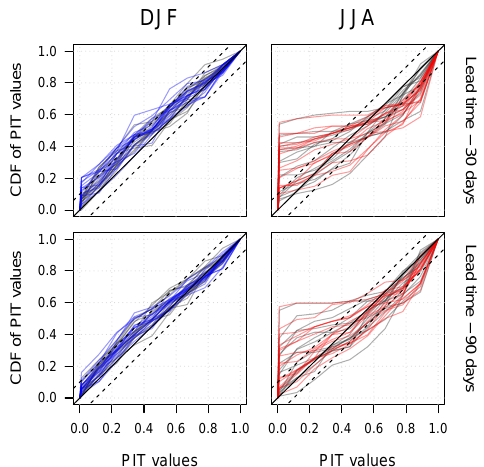
Figure 13. PIT diagram of streamflow forecasts obtained from pre- cipitation forecasts bias corrected with EDMD-m (coloured lines) and ESP (grey lines) for lead times of 30 days (top) and 90 days (bottom). Each column corresponds to a target season. Each line represents the PIT diagram in a catchment for forecast horizons within the target season. Dotted lines represent the ± 0.1 tolerance bands from the diagonal.